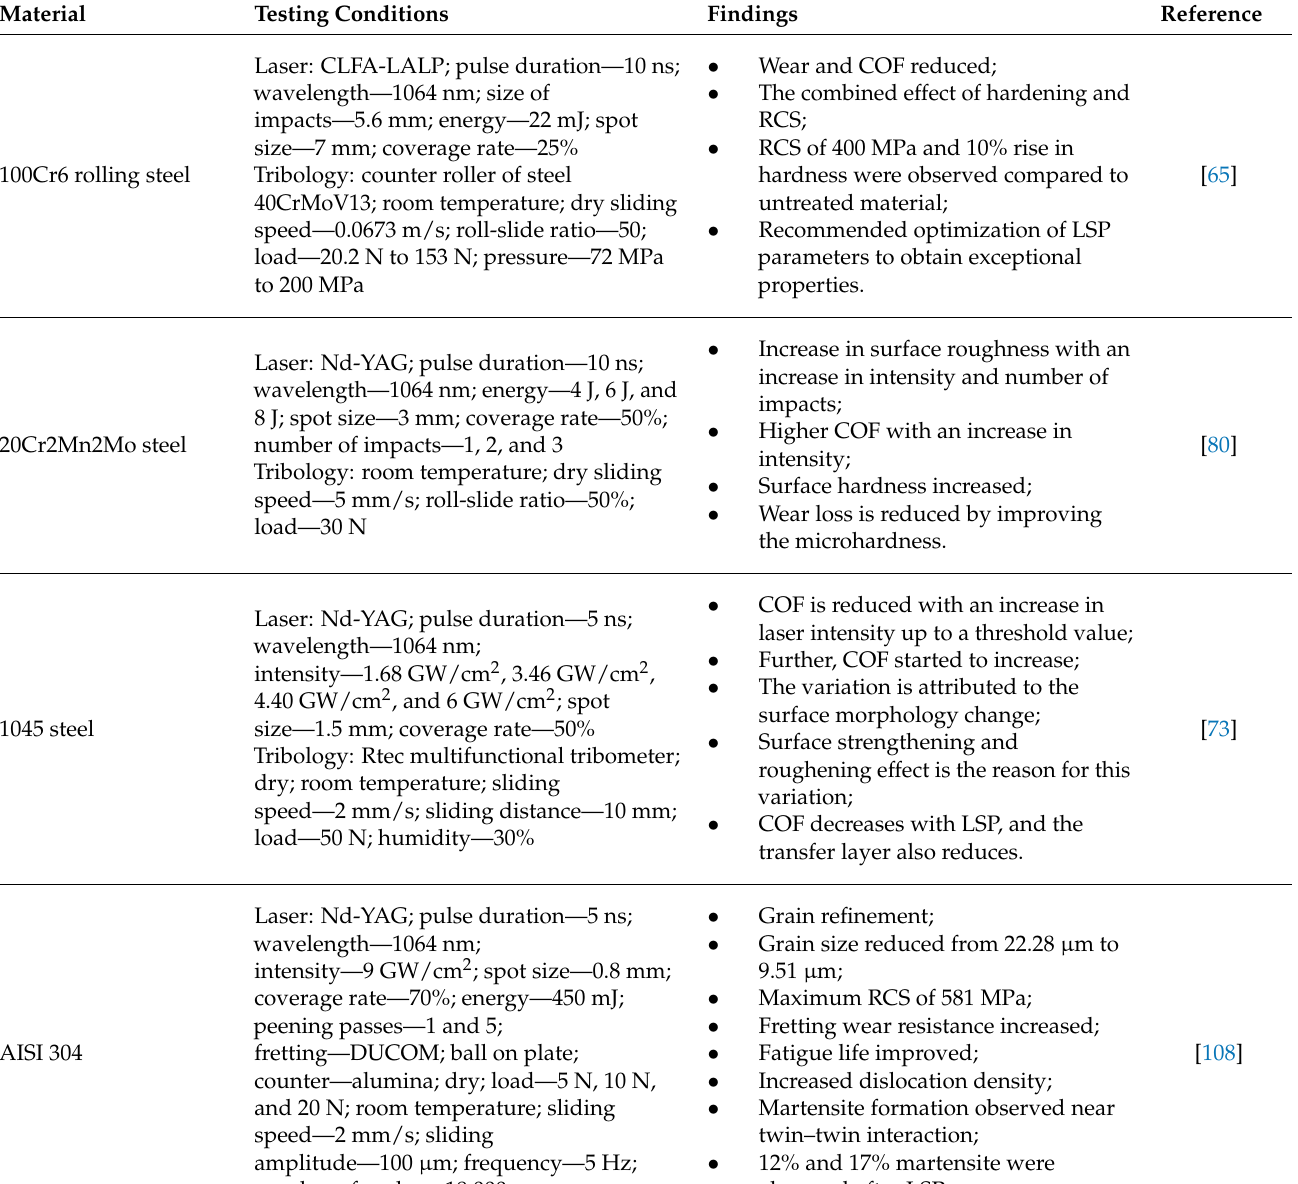
Table 2. Effect of LSP on tribological and other mechanical